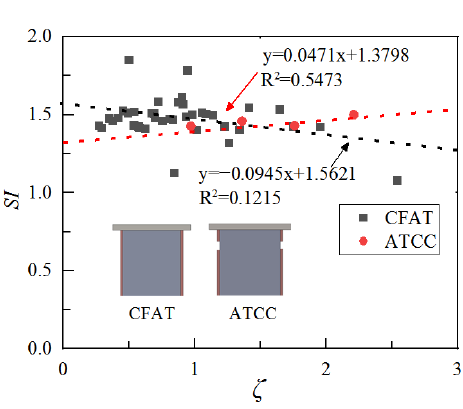
Figure 9. SI –ζ relationship. Figure 9. SI– ζ